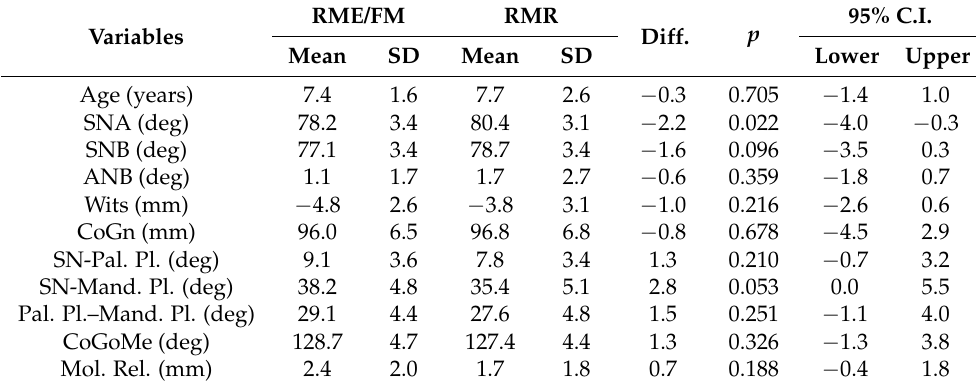
Table 1. Descriptive statistics and statistical comparisons (independent sample t test) for the starting forms (T1).